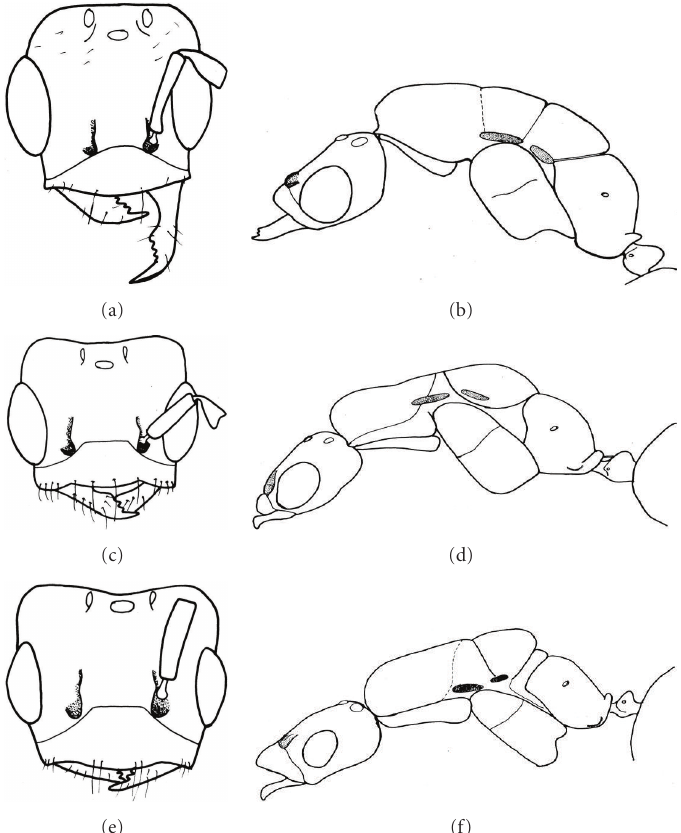
Figure 10: Males of three Dorymyrmex species. (a), (c), and (e) Heads of (a) Dorymyrmex brunneus ; (c) Dorymyrmex insanus ; (e) Dorymyrmex pyramicus ; (b), (d), and (f) body profiles of (b) Dorymyrmex brunneus ; (d) Dorymyrmex insanus ; (f) Dorymyrmex pyramicus.